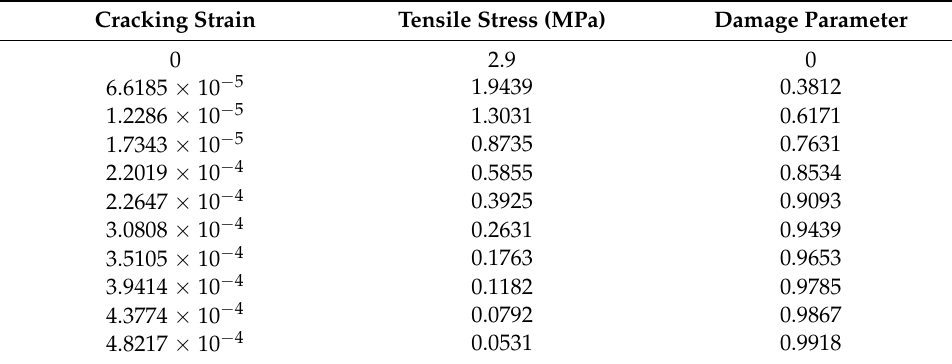
Table 2. Inelastic tensile behavior of